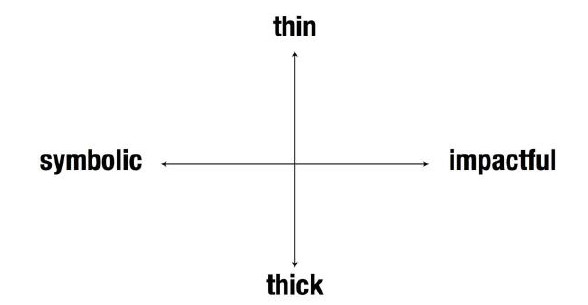
Figure 1. Zuckerman’s 2-D matrix for thinking about civic engagement activities. Source: Zuckerman